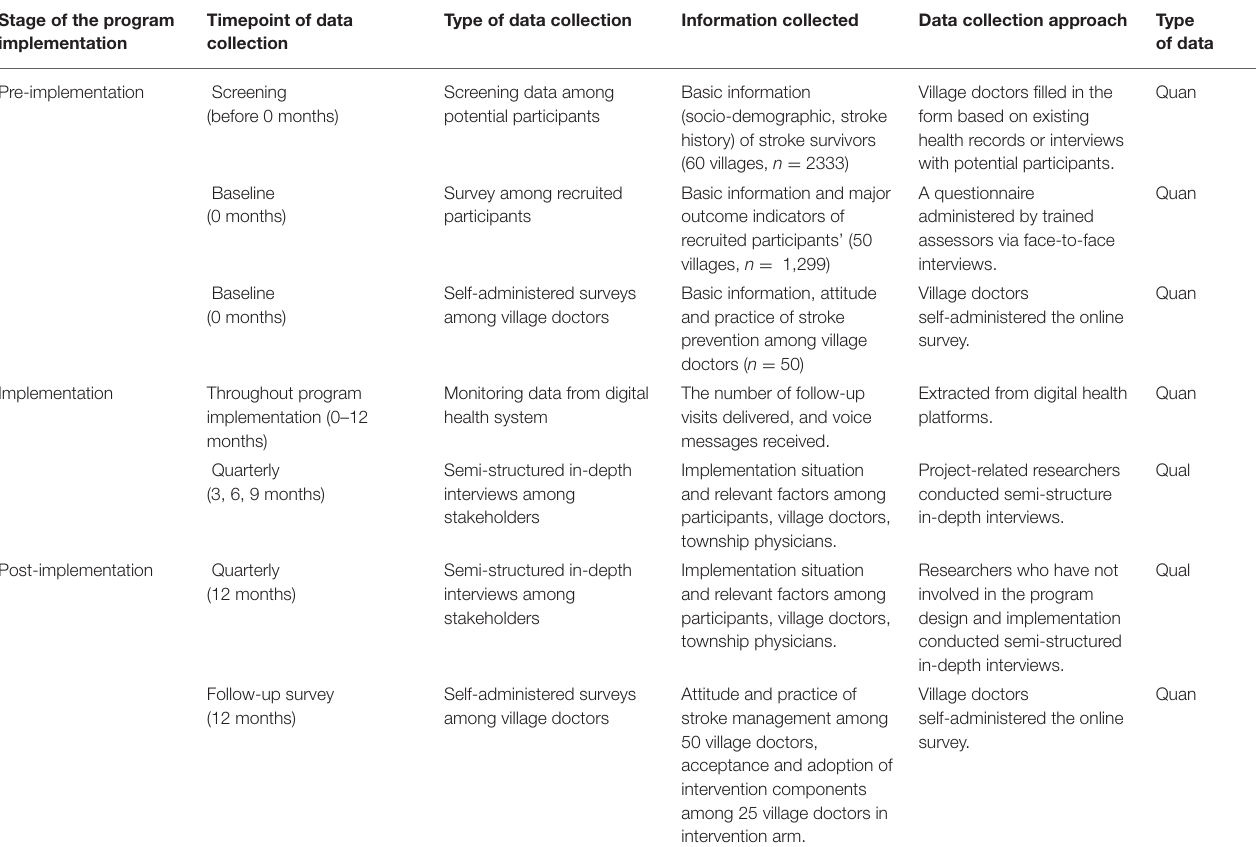
TABLE 1 | Data sources and data collection